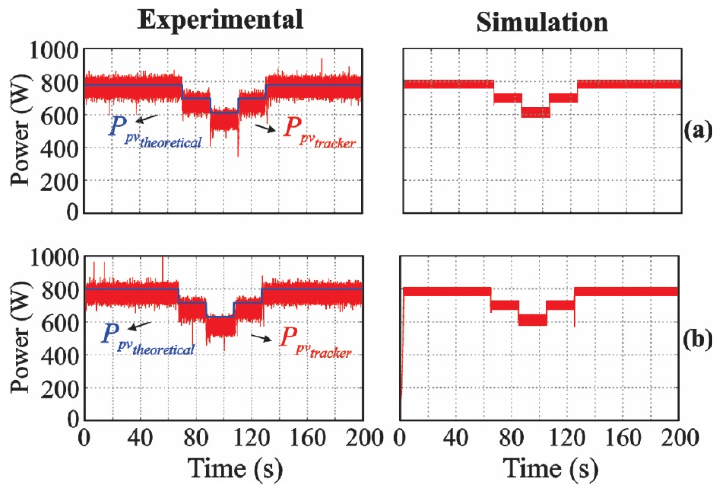
Figure 12. Experimental and simulated results regarding the PV array output power under temperature changes: ( a ) current sensorless proposed algorithm; ( b ) classical IncCond algorithm. Table 7. Comparison between the proposed and the classical IncCond algorithms under steps of temperature.